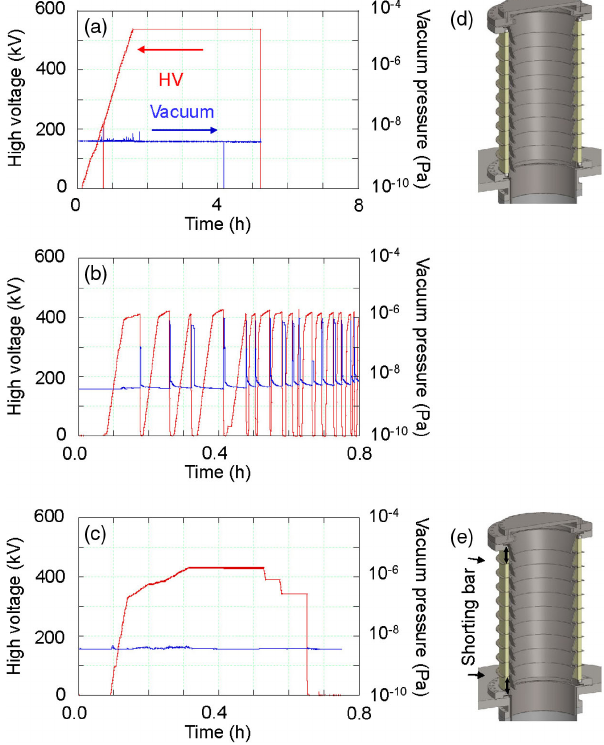
FIG. 2. HV testing without the central stem electrode. HV (red curve) and vacuum pressure (blue curve) as a function of time measured (a) at JAEA and (b) at the cERL just after installation of the gun. The insulator configuration for both measurements is given in (d). HV and vacuum pressure at the cERL with top and bottom segments short-circuited (c). The insulator configuration is given in